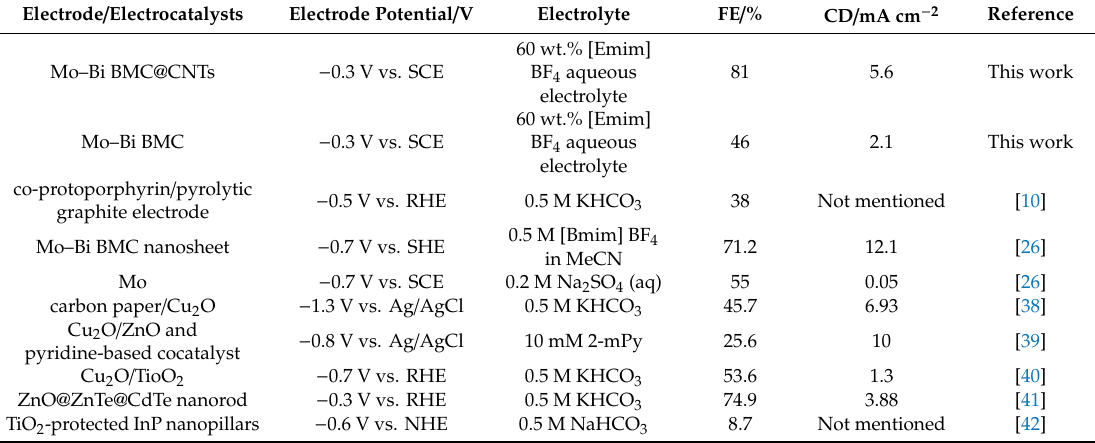
Table 3. The Faradaic e ffi ciency (FE) of methanol and the current density (CD) in CO 2 reduction using various electrodes and electrolytes. Saturated calomel reference electrode (SCE), Reversible hydrogen electrode